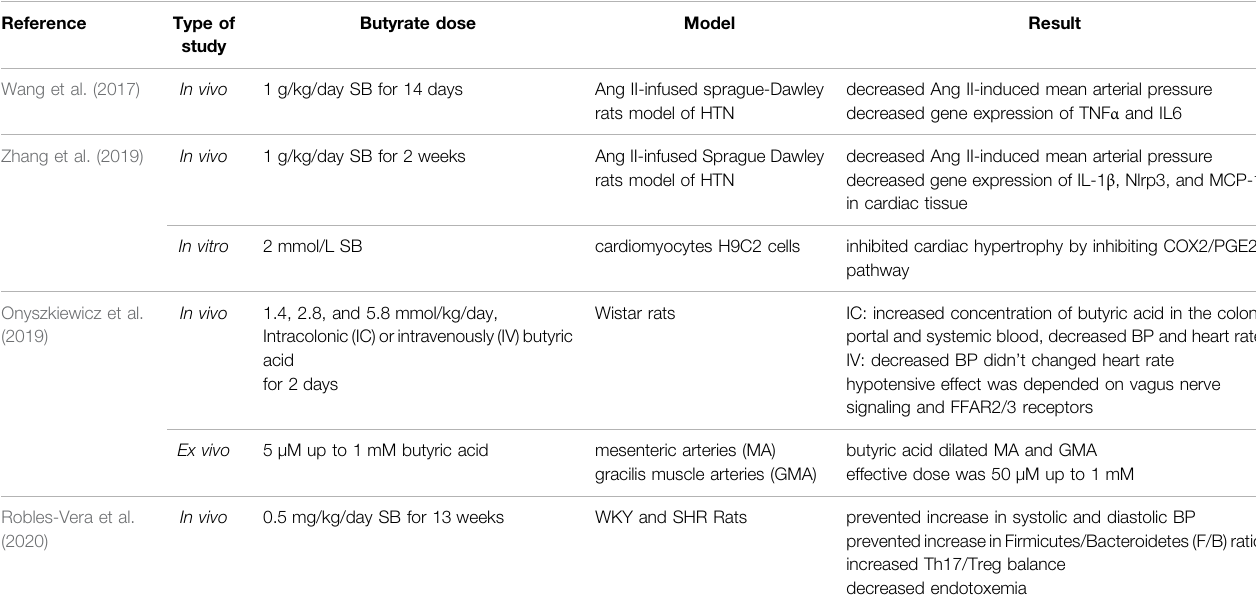
TABLE 3 | Summary of the studies about the effects of butyrate on